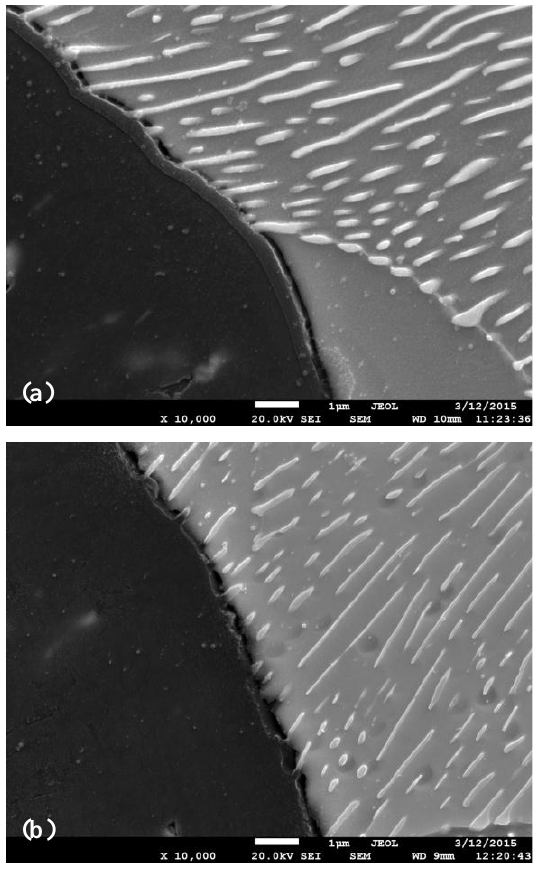
Figure 16. SEM images of SGI-3 ( a ) before and ( b ) after thermal cycling